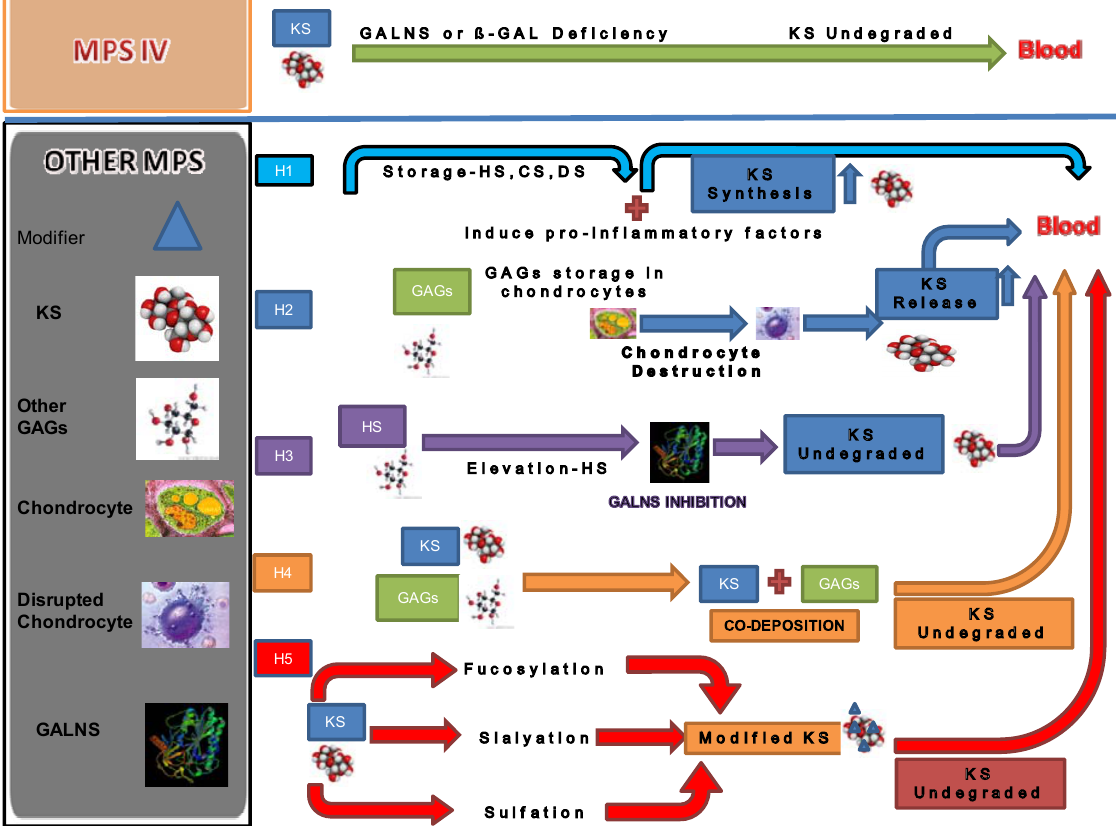
Figure 5. Hypotheses (H) of secondary elevation of blood KS in other MPS. H1; Accumulation of GAGs and pro-inflammatory factors induces KS synthesis. H2; GAG storage in chondrocyte leads to cell death and release of KS. H3; Accumulated HS leads to inhibition of GALNS activity. H4; Other GAGs co-deposited with KS masks the access of degradative enzymes for KS and undegraded KS is too large for filtration in kidney. H5; Fucosylation, sialyation, or sulfation modification of KS leads to resisting